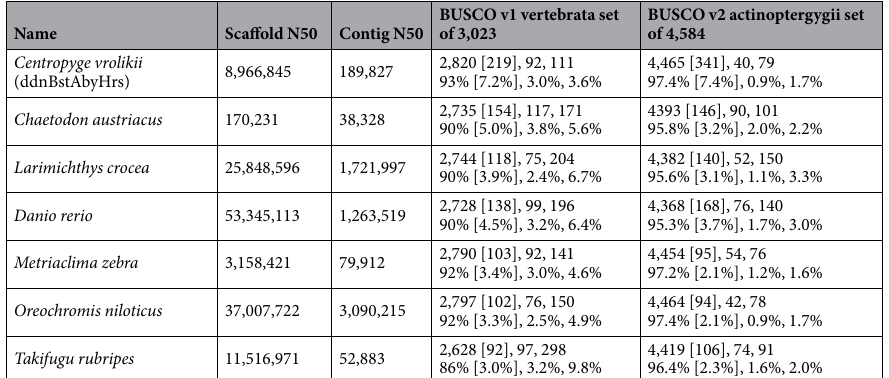
Table 2. Summary of quantitative measures for selected fish genomes. For BUSCO v1 and v2 values, the first line is the count of complete matches [count of duplicate completenes], count of fragmented, count of missing. The second line is percent of complete matches [percent duplicate completes], percent fragmented, percent